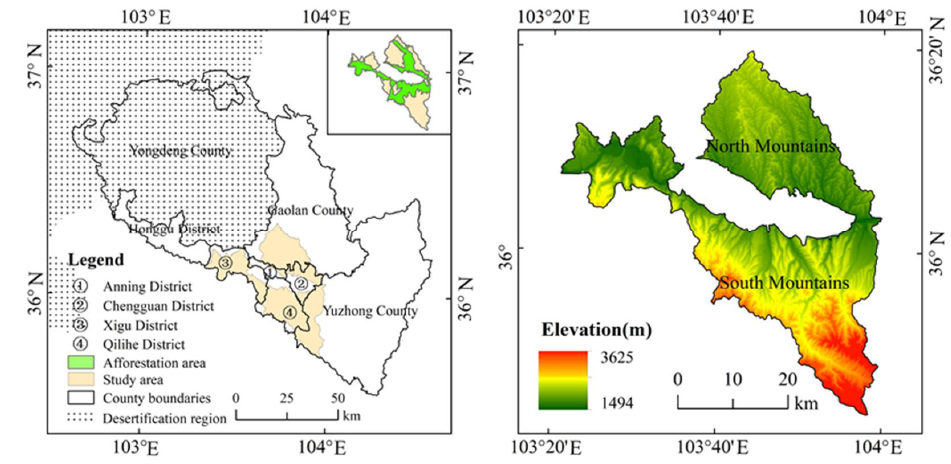
Figure 1. Overview of the study area.